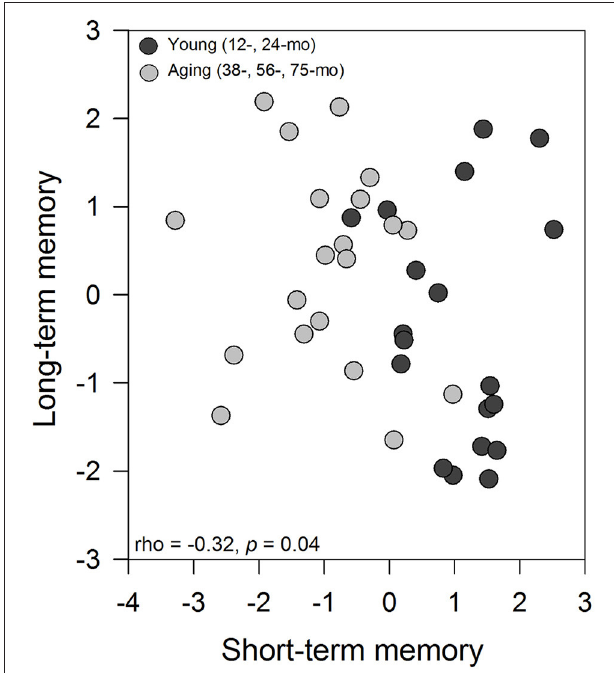
FIGURE 2 | Association between the first axis of PCA from the short-term memory analysis with the first axis from long-term memory using Spearman’ rank correlation coefficient. Each data point represents a degus, and symbols represent the age group of animals (black circle: young degus (12- and 24-months-old); gray circle: aged degus (38-, 56-, and